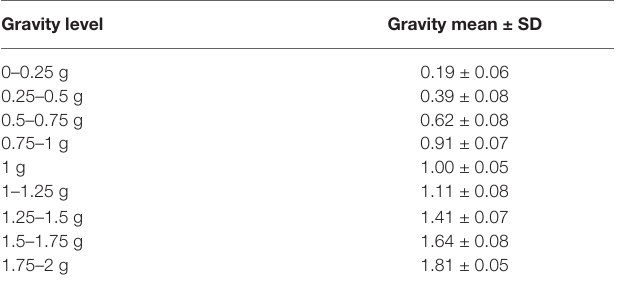
TABLE 1 | Gravity levels identified by obtaining the gravity for three discrete DJ time points (150 ms before ground contact, instant of GC, and instant of PO) and two time intervals (from GC until PO and from 150 ms before GC until PO) – see